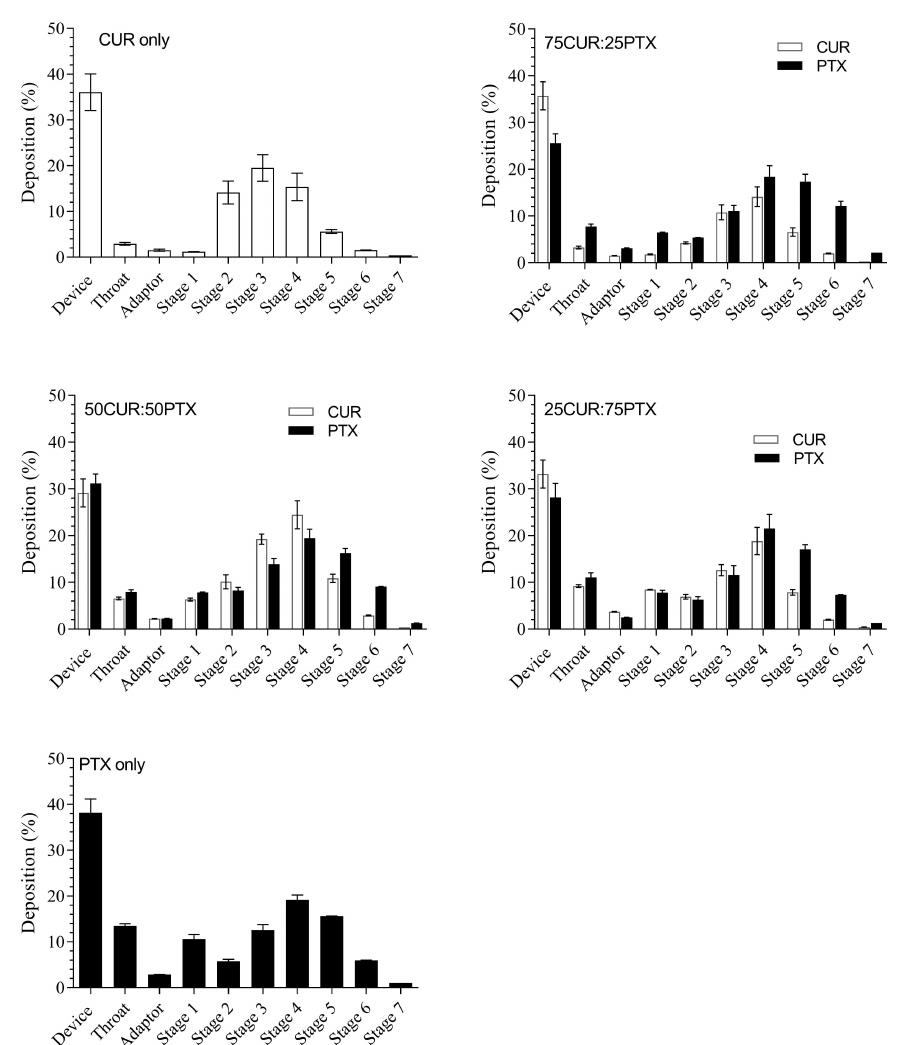
Figure 3. In vitro aerosol deposition of the milled CUR, PTX and combination formulations using NGI at a flow rate of 60 L/min with HR RS01 DPI device. Data represent mean ± SD (n = 3). Black bar denotes PTX and white bar denotes CUR. Data are expressed as mean ± SD of three